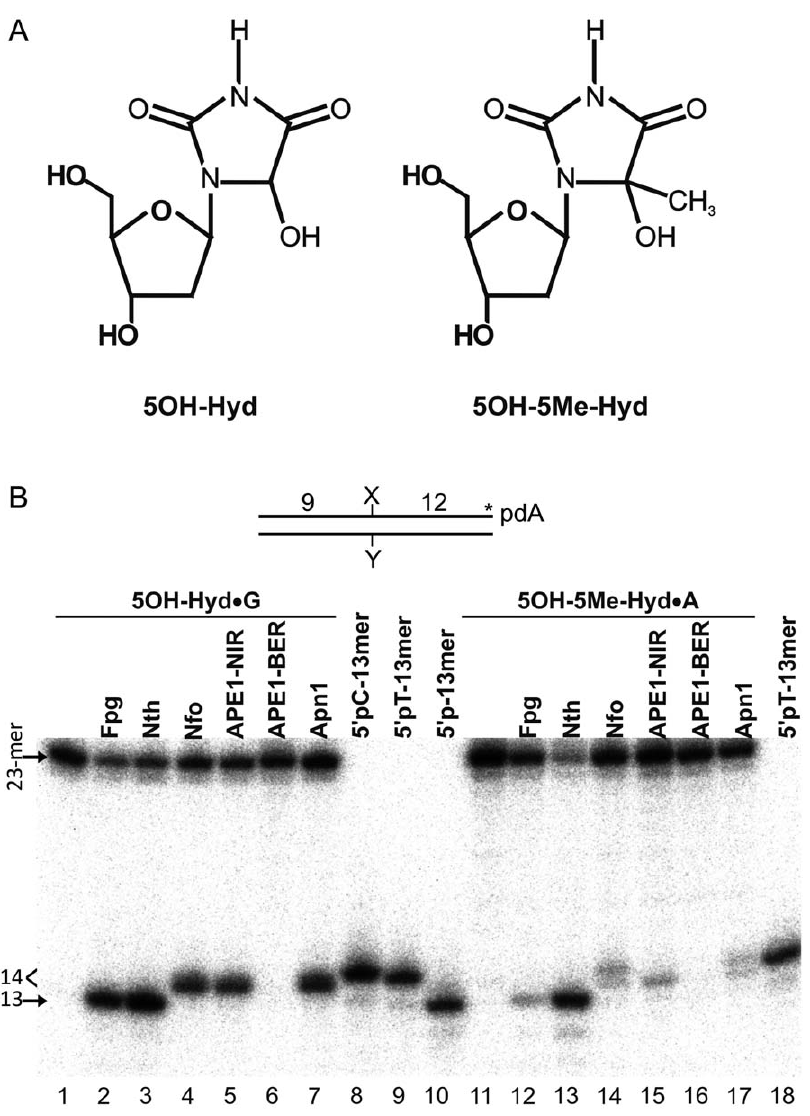
Figure 1. Pyrimidine hydantoins are substrates for the NIR and BER pathways. ( A ) Chemical structures of 5-hydroxyhydantoin-2 9 - deoxynucleoside (5OH-dHyd) and 5-hydroxy-5-methylhydantoin-2 9 -deoxynucleoside (5OH-5Me-dHyd). ( B ) Denaturing PAGE analysis of the cleavage products after incubation of the 3 9 -[ 32 P]-labelled 5OH-Hyd N G (lanes 1–7) and 5OH-5Me-Hyd N A (lanes 11–18) duplex oligonucleotides with the DNA glycosylases/AP lyases (10 nM) and AP endonucleases (0.5 nM) of different origins. Lanes 1 and 11, control no enzyme; lanes 4 and 14, Nfo; lanes 5 and 14, APE1 under NIR conditions; lanes 6 and 15, APE1 under BER conditions; lanes 7 and 17, Apn1; lanes 2 and 12, Fpg; lanes 3 and 13, Nth; size markers: lane 8, 14-mer fragment with 5 9 -terminal pdC nucleotide; lanes 9 and 18, 14-mer fragment with 5 9 -terminal pT nucleotide; lane 10, 13-mer fragment with 5 9 -phosphate. For details see Materials and Methods. The arrows and ‘‘ , ’’ symbol denote the position of the 23-mer, 13-mer and 14- mer fragments, respectively. doi:10.1371/journal.pone.0021039.g001 Nfo showed two mono-charged cleavage product peaks: one at mono- and bi-charged peaks corresponding to the complementary [M-H] 2 = 2696 Da corresponding to the 9-mer oligonucleotide strand ([M-H] 2 and [M-2H] 2 2 , respectively). Importantly, the released 5 9 upstream to the lesion 5 9 -CACTTCGGA ([M-H] 2 respective amounts of cleavage fragments containing ureido and with calculated mass 2698 Da), and the other one with molecular 5OH-Hyd varied among the experiments. As shown in Figure 2B, mass [M-H] 2 =3953 Da corresponding to a 13-mer oligonucle- the spectrum of products after incubation of 5OH-5Me-Hyd with otide 5 9 -p-ZTGTGACTGATCC (Figure 2A). While, the expected Nfo contains a peak corresponding to the 13-mer 5 9 -p- Nfo-cleavage fragment 5 9 -p-XTGTGACTGATCC released 3 9 XTGTGACTGATCC with [M-H] 2 = 4023 Da which closely corresponds to calculated [M-H] 2 = 4023.5 Da and an additional downstream to the lesion should have a calculated mass [M- peak with [M-H] 2 = 3953.5 Da corresponding to the 13-mer 5 9 -p- H] 2 = 4009.5 Da. The difference of 56.5 Da between expected mass and experimental value suggest that 5OH-Hyd residue (X of ZTGTGACTGATCC that contains an ureido residue. As 116 Da) is decomposed to an ureido residue (Z of 59 Da). In expected the MALDI-TOF MS analysis did not reveal any addition to the cleavage products we can see the presence of the cleavage of the complementary strands (Figure 2).